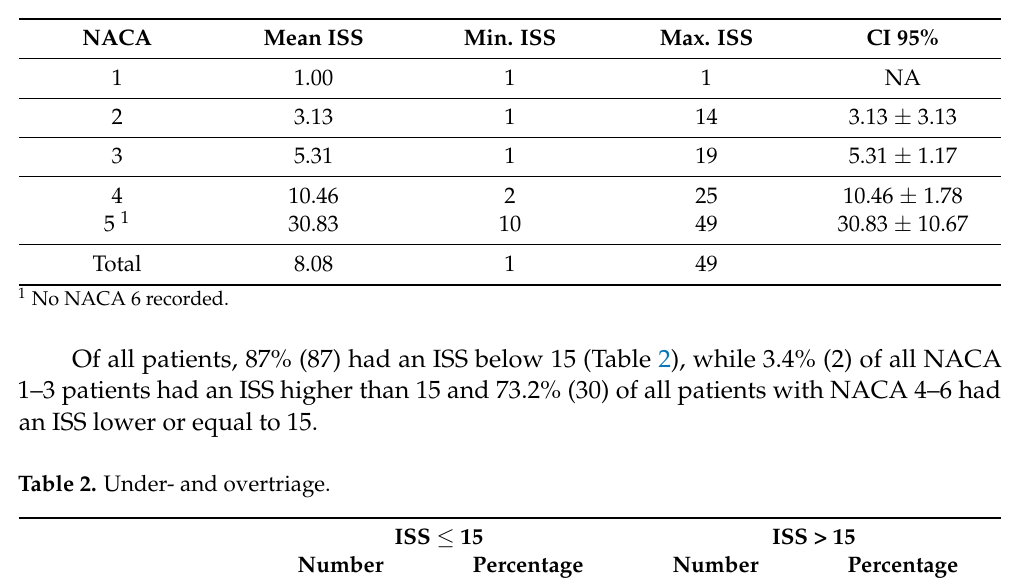
Table 1. NACA and ISS.